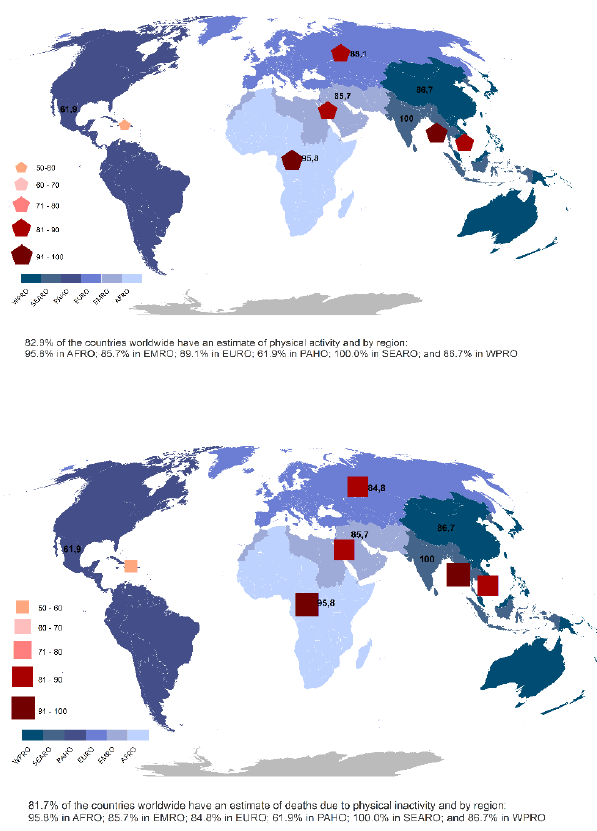
Figure 1. Global prevalence of physical activity and global deaths due to physical inactivity. Adapted with permission from